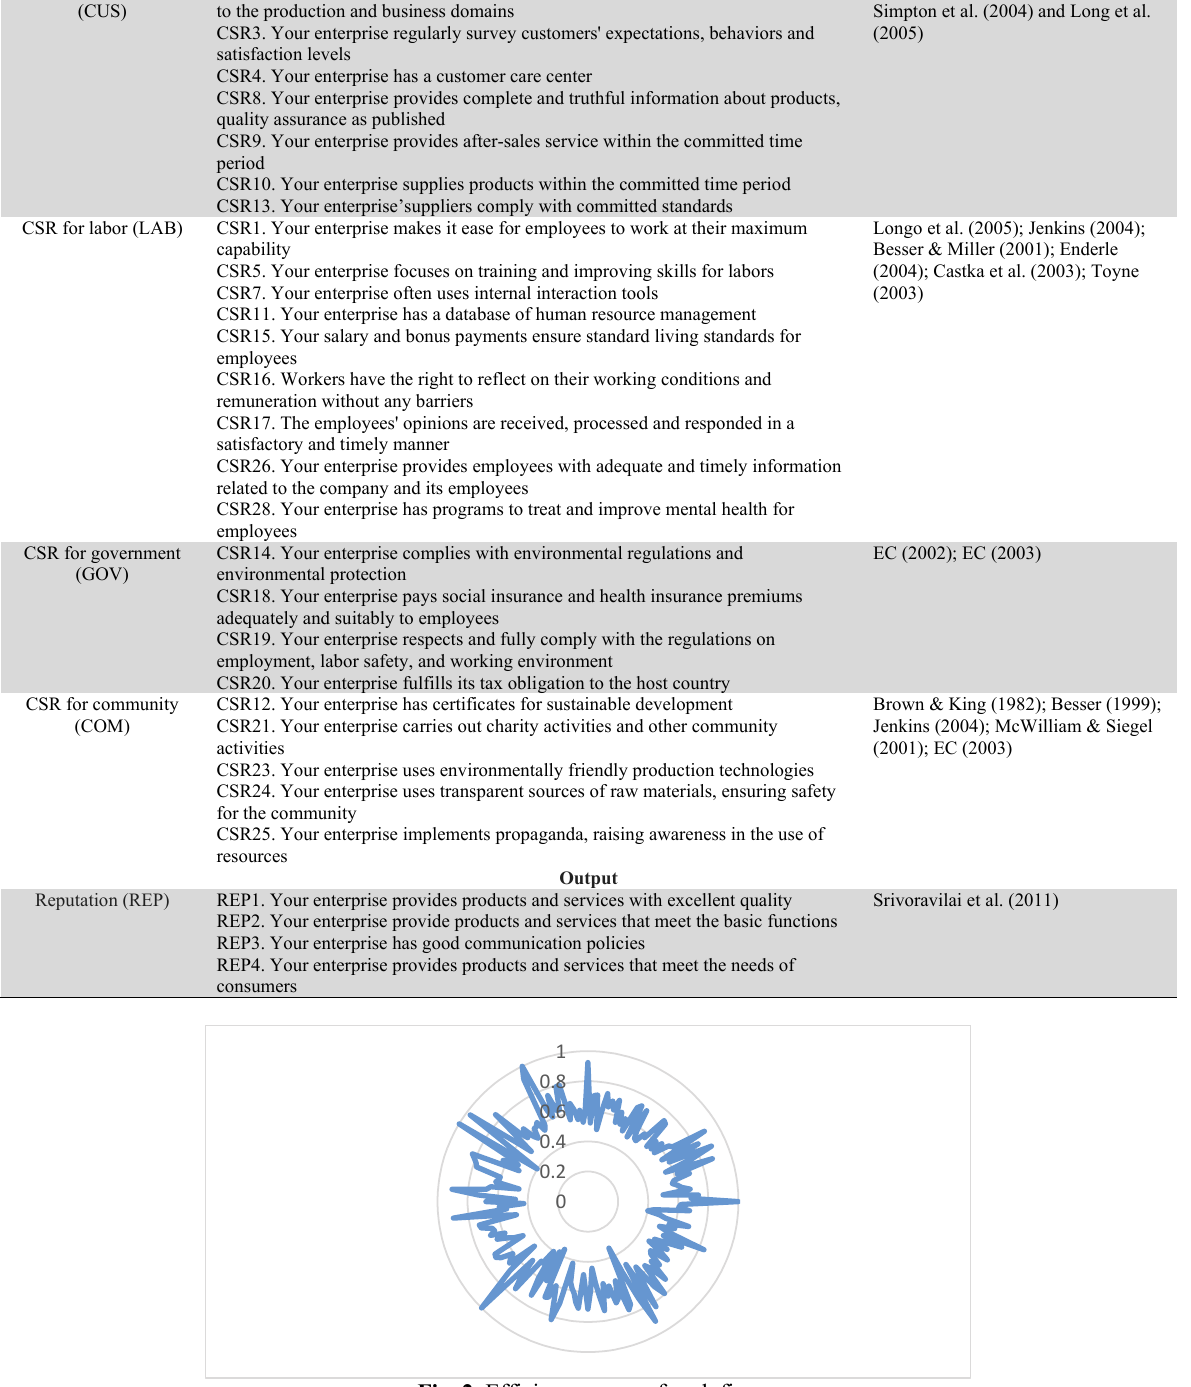
Fig. 2. Efficiency score of each